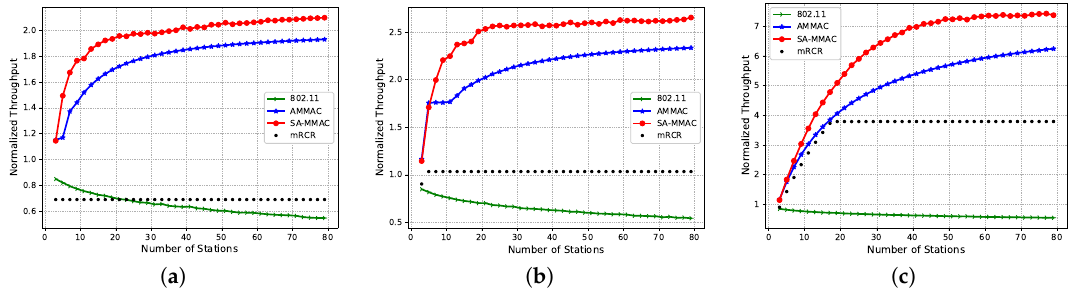
Figure 4. Comparison of the saturated throughput for SA-MMAC with others. ( a ) 3 channels; ( b ) 4 channels; ( c ) 12 channels.